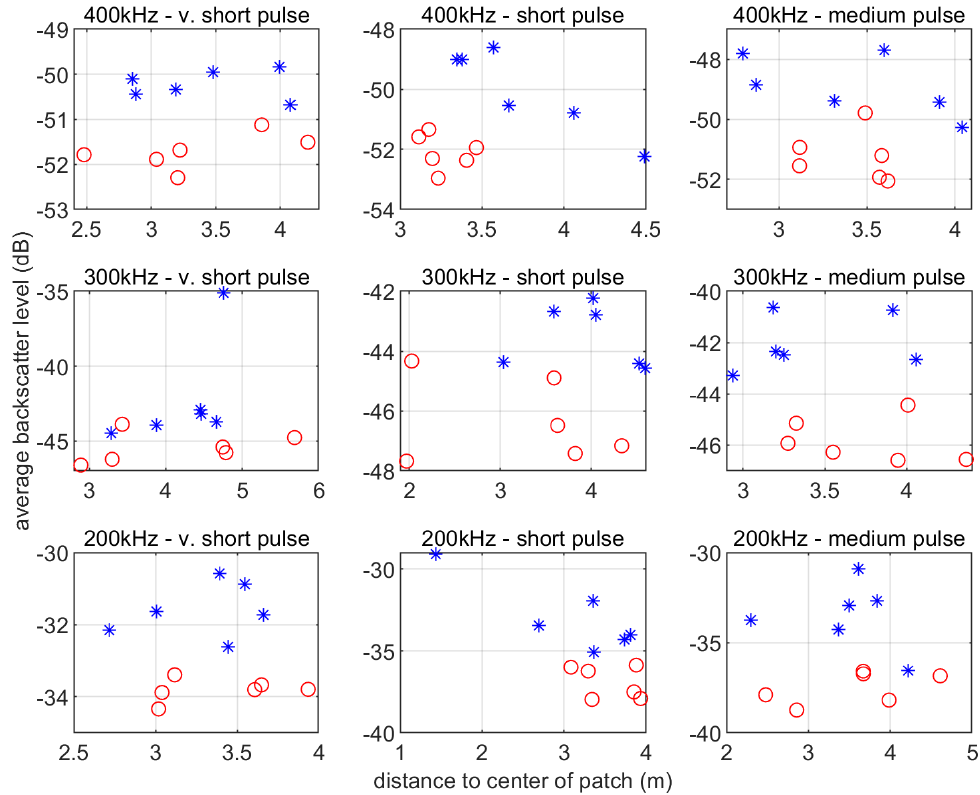
Figure 11. Average of the filtered backscatter level recorded within the target volume as a function of the shortest horizontal distance to the patch. Each of the nine plots displays the data for one combination of the sonar settings: ( top left ) 400 kHz and 25 µ s pulse, ( top ) 400 kHz and 50 µ s pulse, ( top right ) 400 kHz and 100 µ s pulse, ( left ) 300 kHz and 25 µ s pulse, ( middle ) 300 kHz and 50 µ s pulse, ( right ) 300 kHz and 100 µ s pulse, ( bottom left ) 200 kHz and 25 µ s pulse, ( bottom ) 200 kHz and 50 µ s pulse, ( bottom right ) 200 kHz and 100 µ s pulse. Colours and symbols di ff er for the dense forest patch (blue stars) and thin forest patch (red circles).